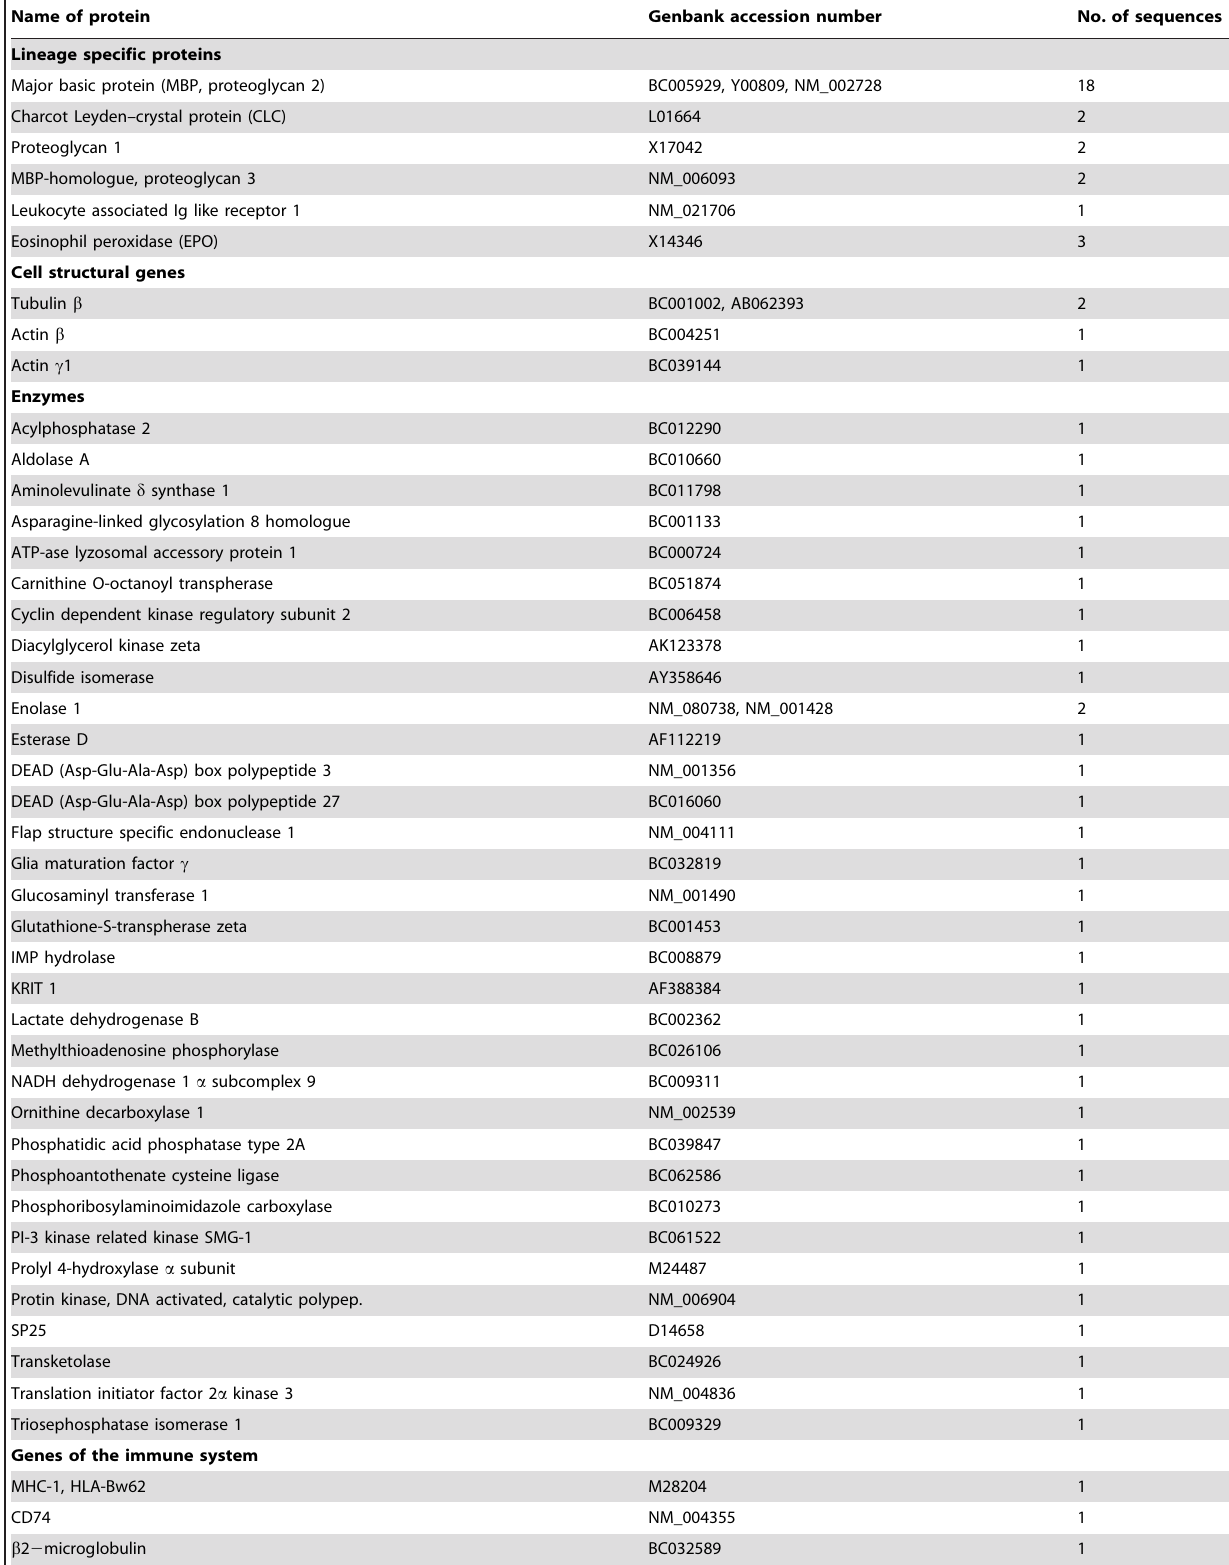
Table 1. Clones isolated from the basophil-like cell cDNA